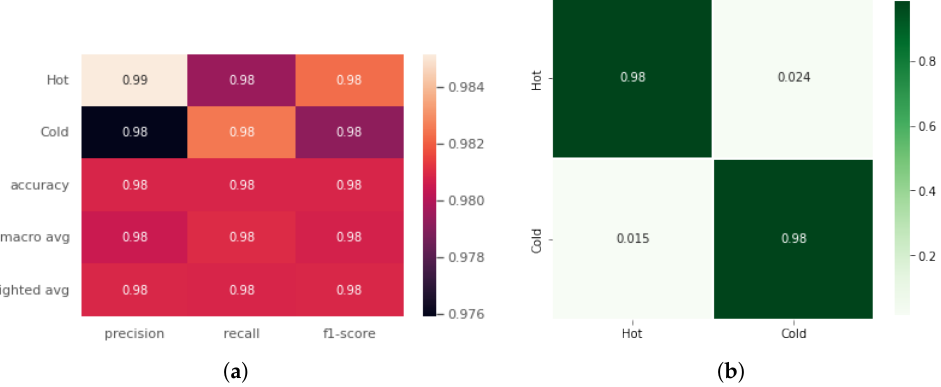
Figure 8. Performance report ( a ) and Confusion matrix ( b ) for hot vs. cold emotions classification. The average classification accuracy, precision, recall, and F1-score remain at 98%.